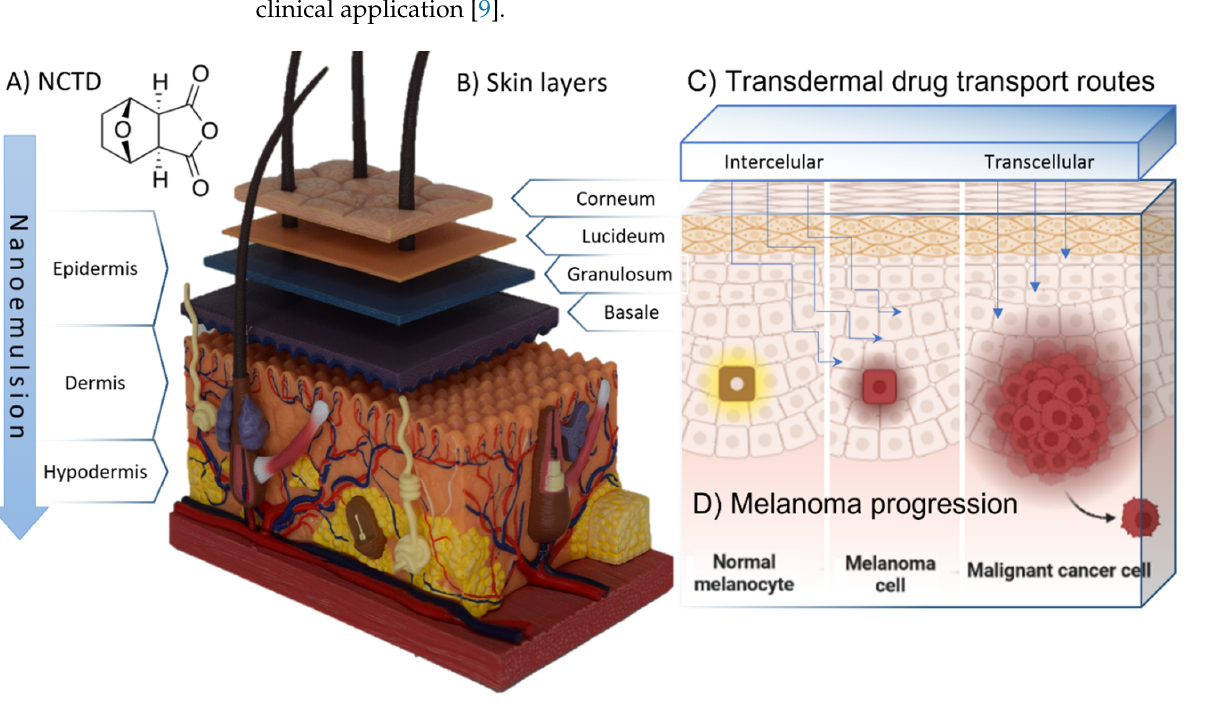
Figure 1. ( A ) Chemical structure of norcantharidin (NCTD) molecule. ( B ) Representation of the skin layers and epidermal strata (skin anatomy model, 4D human anatomy Fame Master ® photography). ( C ) Transdermal formulation drug transport routes (created with BioRender ® ). ( D ) Schematic rep-